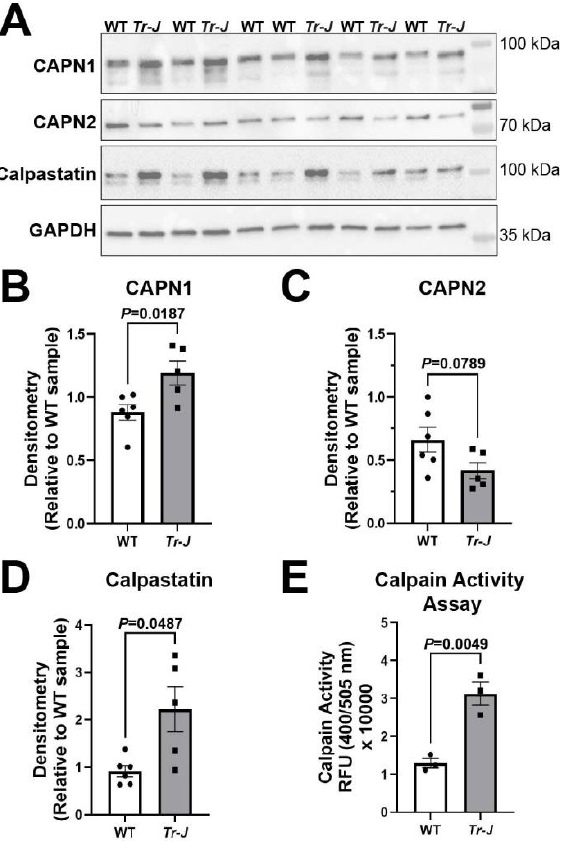
Figure 3. CAPN1 and calpastatin expression and total calpain activity increases in Trembler-J mouse sciatic nerves. ( A ) Immunoblotting from 6 wild-type (WT) and 5 Trembler-J ( Tr-J ) mice. Relative levels of CAPN1, CAPN2, and calpastatin were examined. GAPDH is shown as an internal loading control. Some molecular weight markers were overlaid to illustrate band locations. ( B – D ) Quantitative analysis of immunoblot data in WT and Tr-J mice. Relative density was quantified for CAPN1 ( B ), CAPN2 ( C ), and calpastatin ( D ). Since the CAPN1 full-length and amino-processed bands do not separate well in mouse tissue, the CAPN1 represents the combined full length and amino-processed activated forms. ( B – D ) Data are normalized to internal lane loading control (GAPDH) with mean ± SEM graphed. Student’s t -test was used for comparison of CAPN1 and CAPN2 between WT and Tr-J mice. Welch’s t -test was used for calpastatin analysis due to unequal variances as determined with F test (Supplementary Information S2). ( E ) Calpain substrate cleavage assay performed with sciatic nerves from WT and Tr-J mice. Using a Student’s t -test for comparison, a significant upregulation of calpain activity was observed in Tr-J mice compared to WT mice. Mean ± SEM graphed with n = 3 mice in each group. Detailed results of statistical analyses are provided in the Supplementary Information S2.